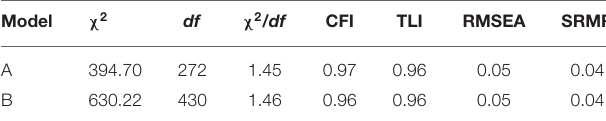
TABLE 5 | The model fitting index of the mediating